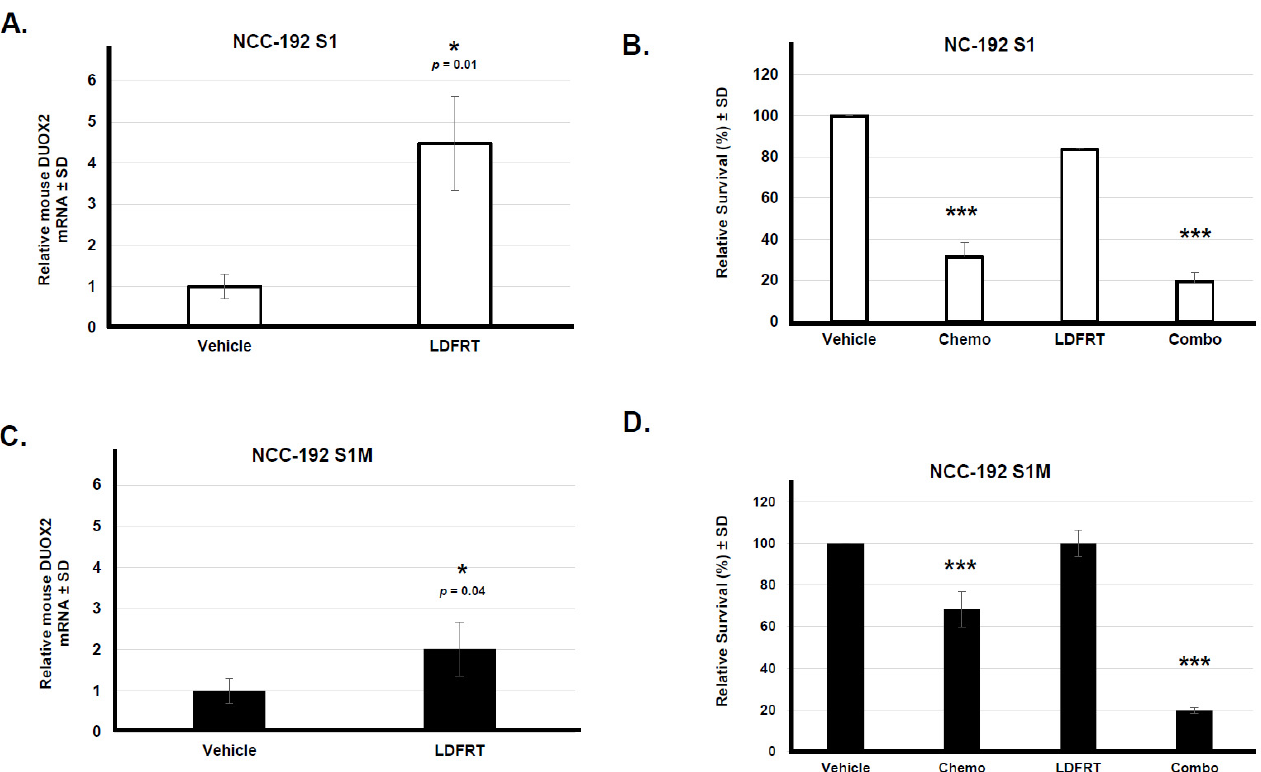
Figure 9. Efficacy of combined regimen in mouse gastric cancer cells. ( A , C ) Expression of DUOX2 mRNA in response to LDFRT in primary mouse gastric cancer cell line NCC-S1 (S1) and its derivative CSC-like NCC-S1M (S1M). Data are compared to their respective untreated samples. * p < 0.05, Student’s t -test. ( B , D ) Clonogenic survival assays were performed in triplicate on cells (NCC-S1, white boxes ( B ) and NCC-S1M, black boxes, ( D )) treated with the indicated treatments. Relative survival is expressed as a percentage of the respective untreated (Vehicle) control. *** p < 0.0005, 1 way ANOVA with Dunnett’s multiple comparison test.